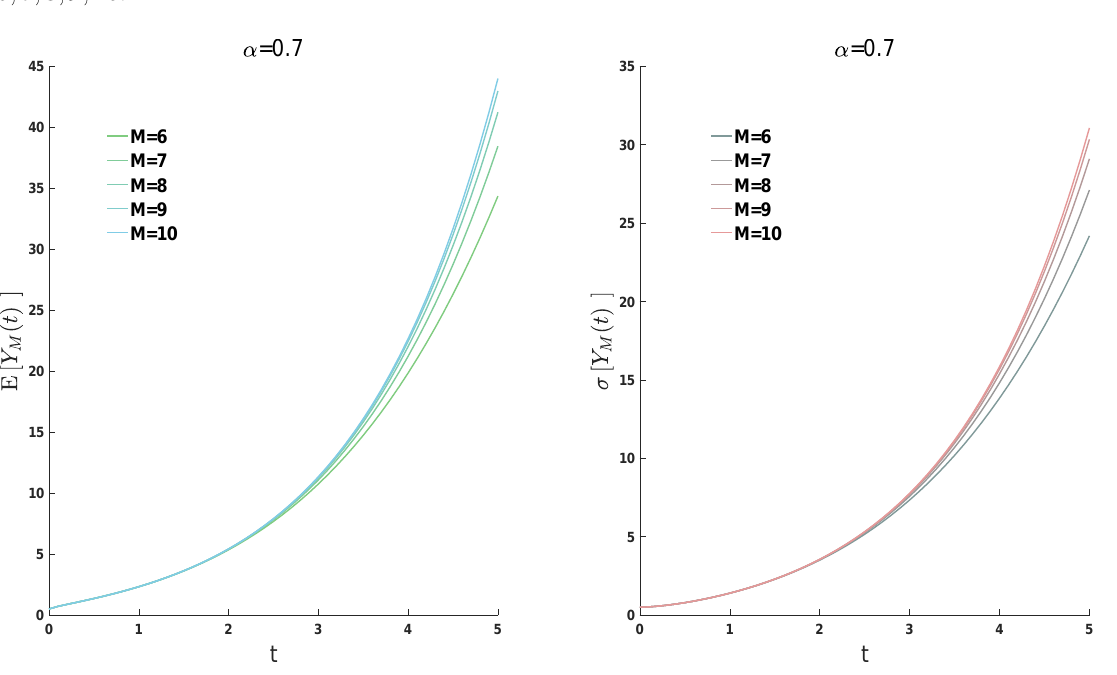
Figure 1 Approximations of the mean (left) and the standard deviation (rigth) of the solution SP to the random IVP (2) with α = 0 . 7 and λ = 3 / 4 using different orders of truncations M = 6 , 7 , 8 , 9 , 10 over the time interval [ 0 , 5 ]